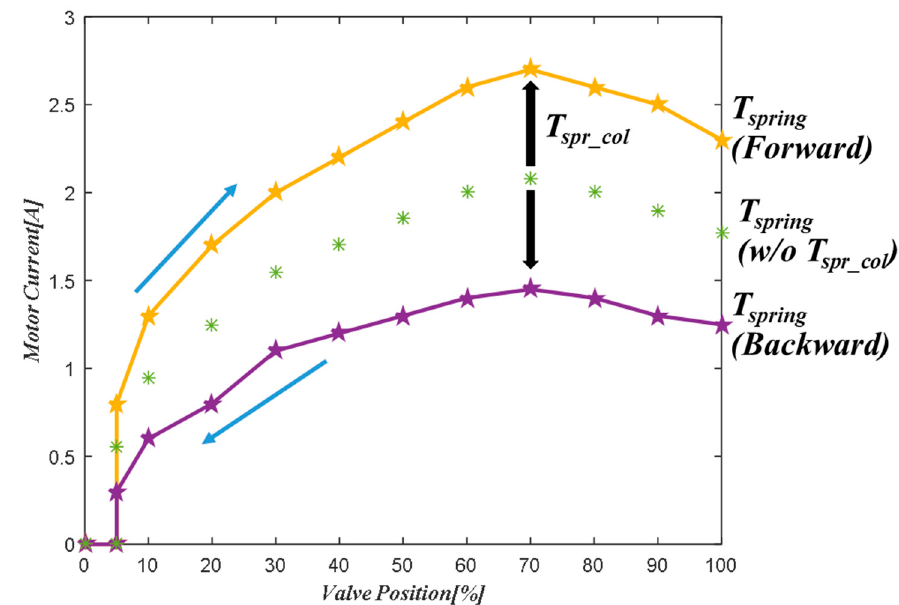
Figure 2. Measured spring torque.